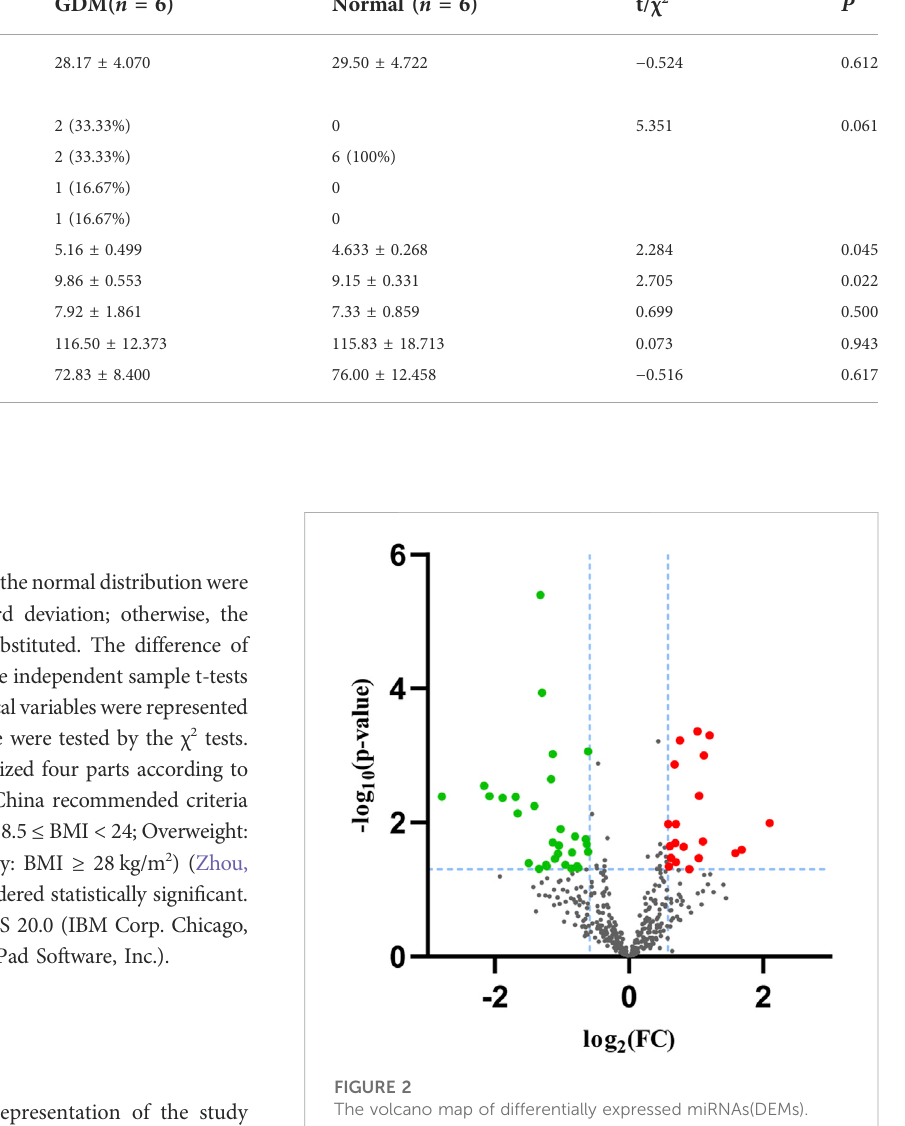
Figure 2. We utilized the web tools TargetScan, miRDB, and miRwalk to explore the overlapped target genes of miRNAs by Venn diagram analysis, as shown in Table2. There were 3,867 target genes for upregulated DEMs and 3,856 target genes for downregulated DEMs after removing those duplicates.